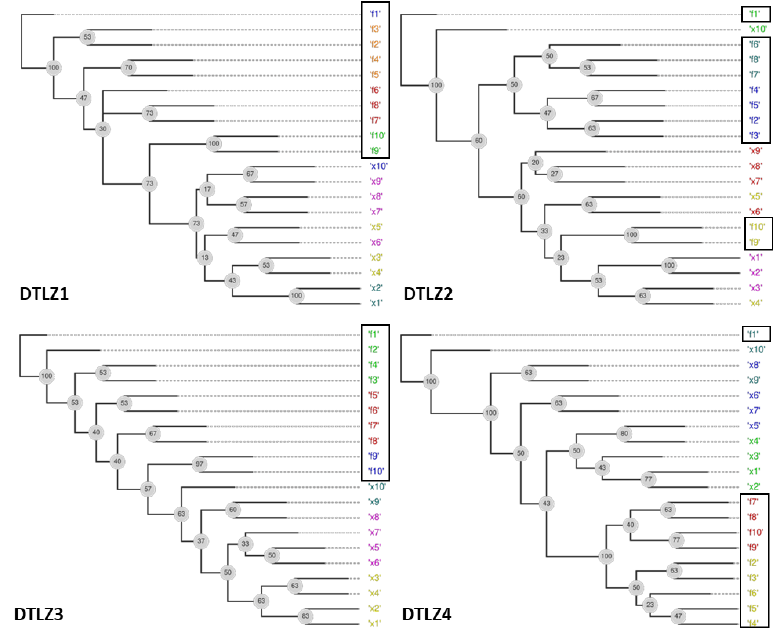
Figure 6. Phylogram and the clusters found for DTLZ1 to DTLZ4 with 10 objectives.